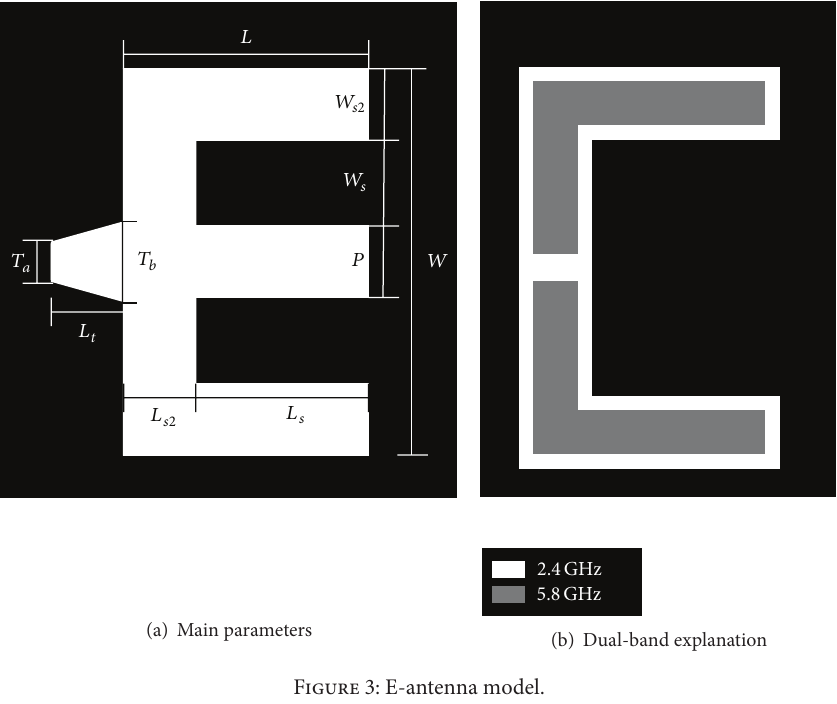
Figure 3: E-antenna